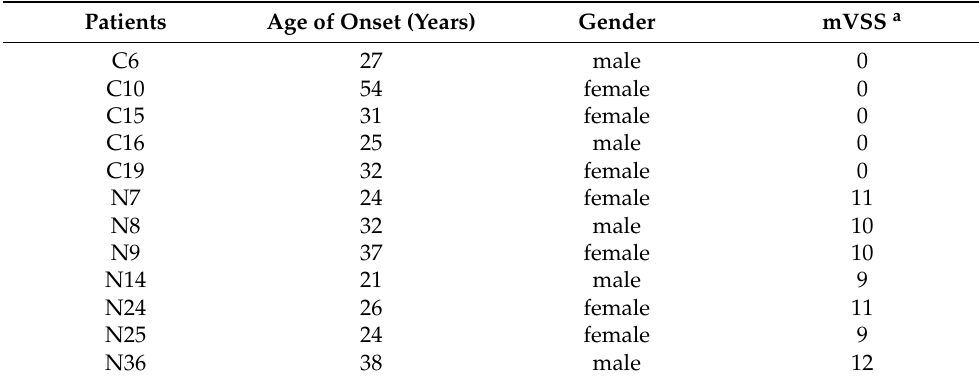
Table 1. Characteristics of patients for